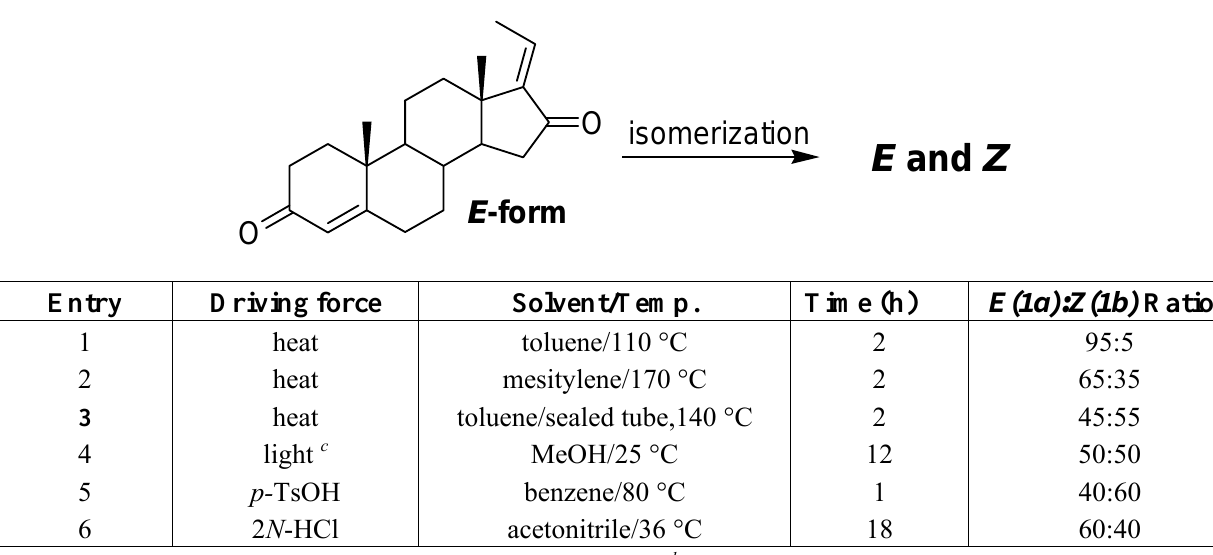
Table 2. Reaction Conditions for Isomerization from E - to Z -Guggulsterone.